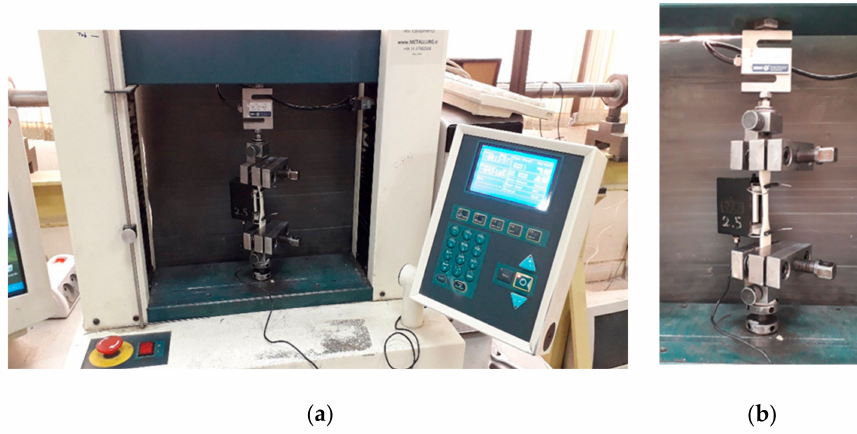
Figure 4. ( a ) Hounsfield-H25KS testing machine; ( b ) a dog-bone specimen under tensile